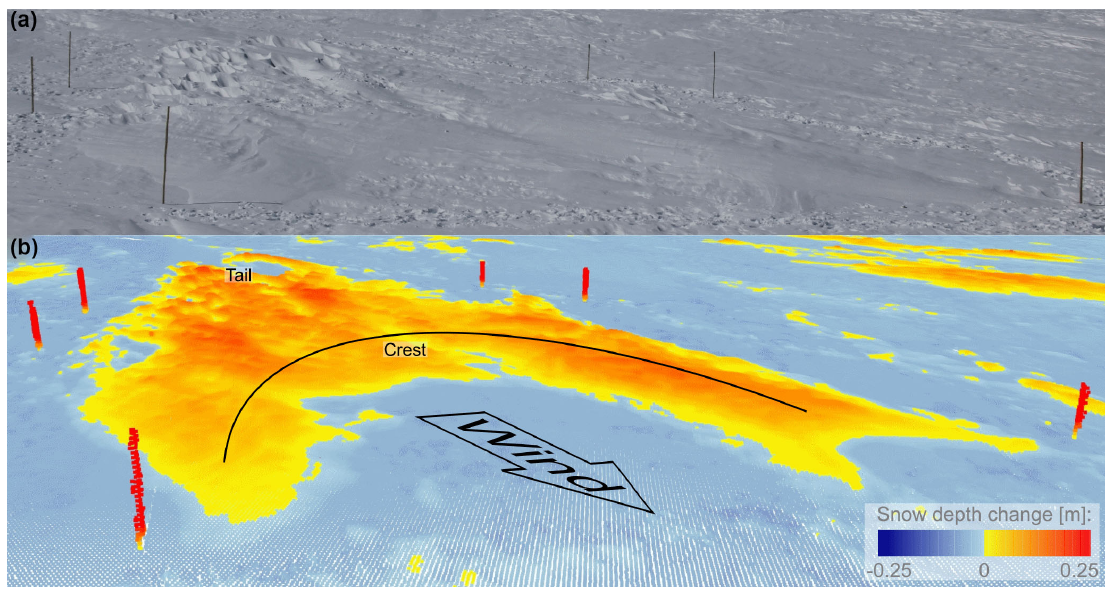
Figure 8. (a) View of a barchan dune from the scan position on 3 January. The bamboo poles mark the position of the three SMP transects in group F measured on that day. Note the zastrugi at the tail of the dune. Panel (b) shows the snow depth changes between 18 December and 6 January from the same direction but at a little steeper angle. The arrow shows the direction in which the wind was blowing. The same nomenclature as in Filhol and Sturm (2015) is used here: the upwind end of the dune is called “tail” and the downwind end is called “crest”. The dune is about 25m long and 11m